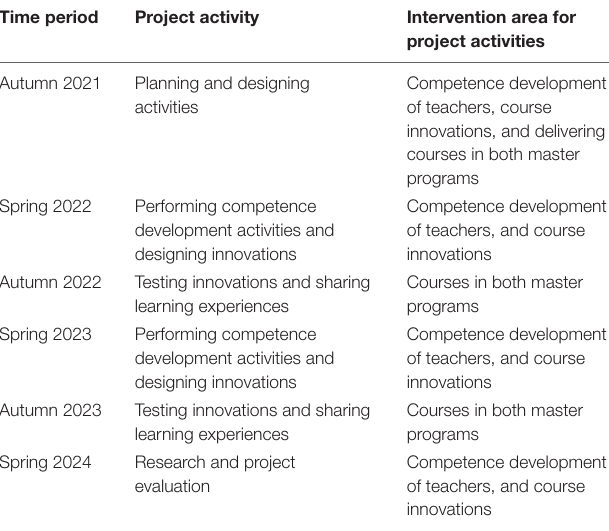
TABLE 1 | Time plan for project activities in the three intervention